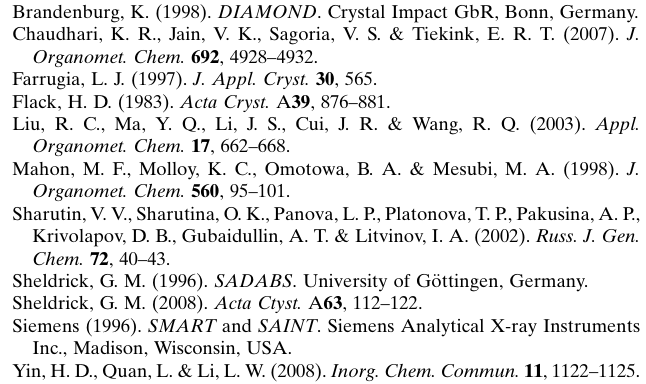
Bruker SMART diffractometer Absorption correction: multi-scan